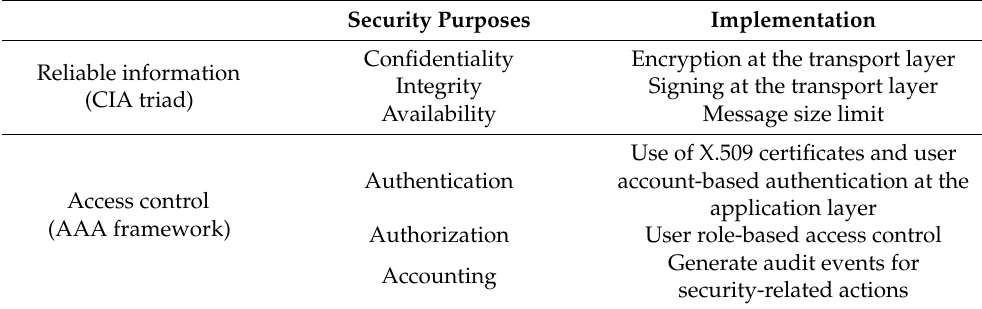
Table 4. OPC UA security